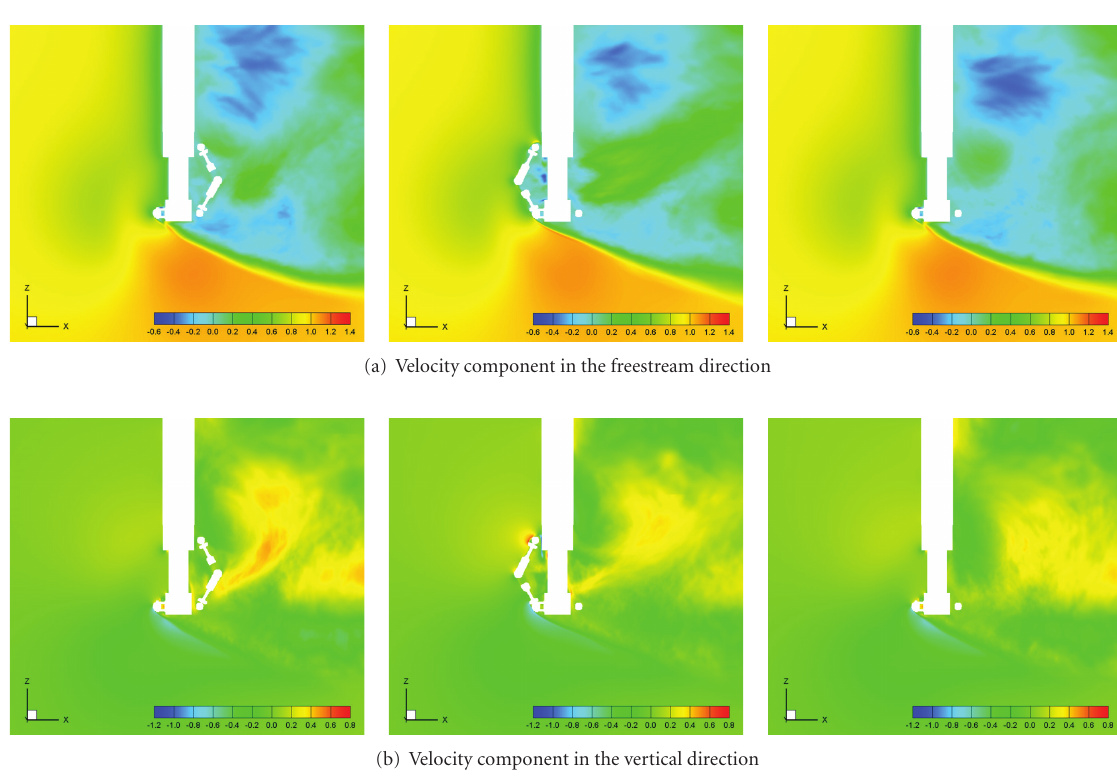
Figure 15: Computed mean velocity component at cross section y = 0 . 0 (left: BACK TEAR, center: FRONT TEAR, right: NO TEAR).